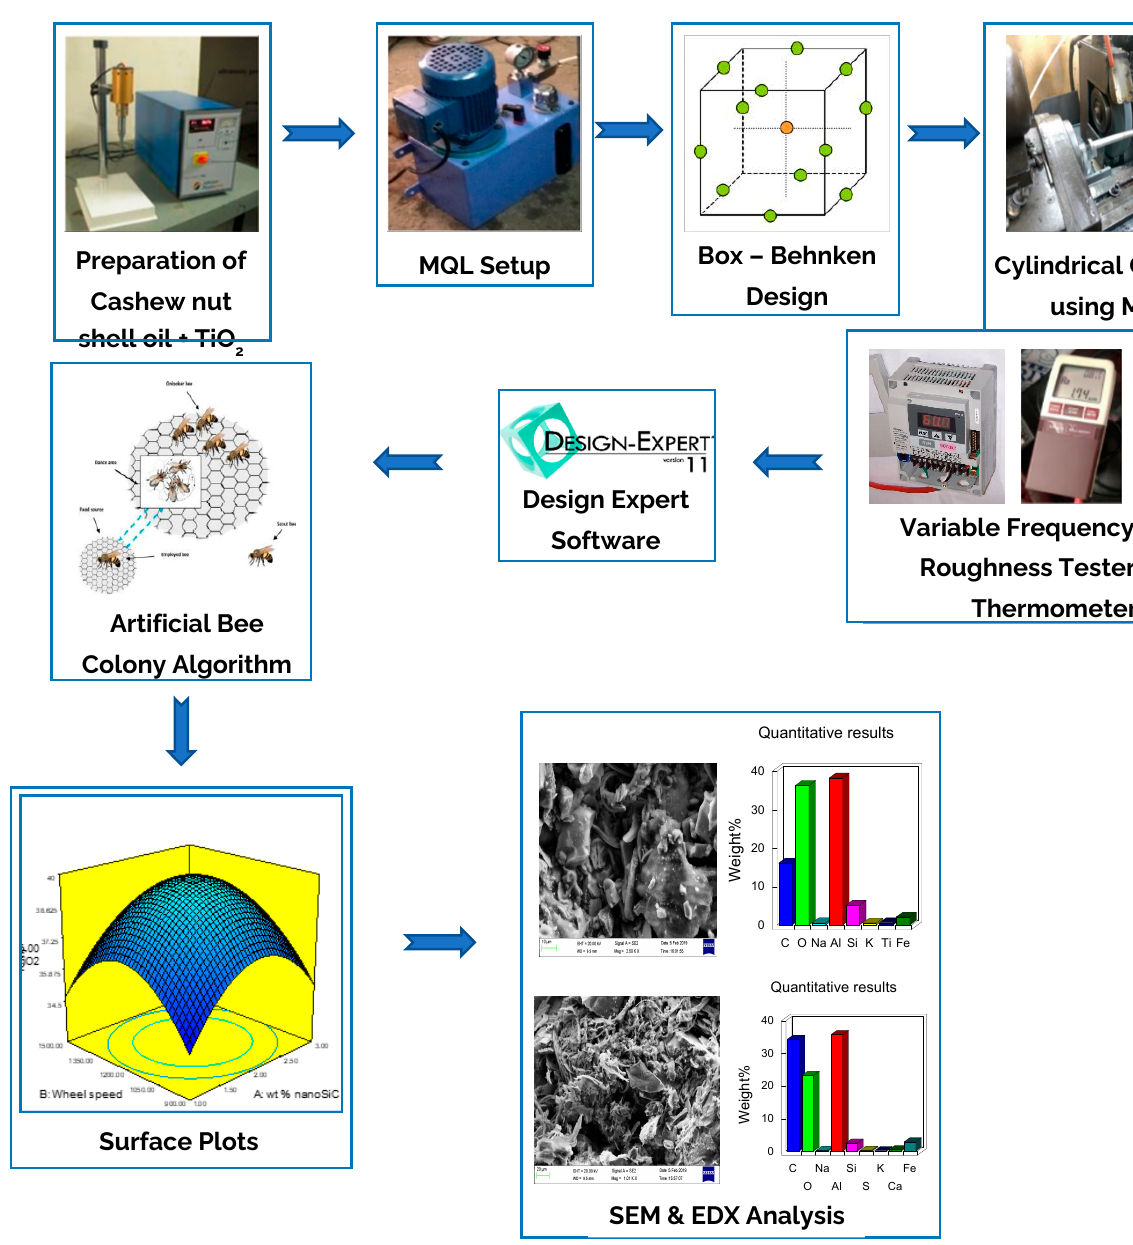
Figure 5. Schematic arrangement of experimental setup. Table 4. Experimental